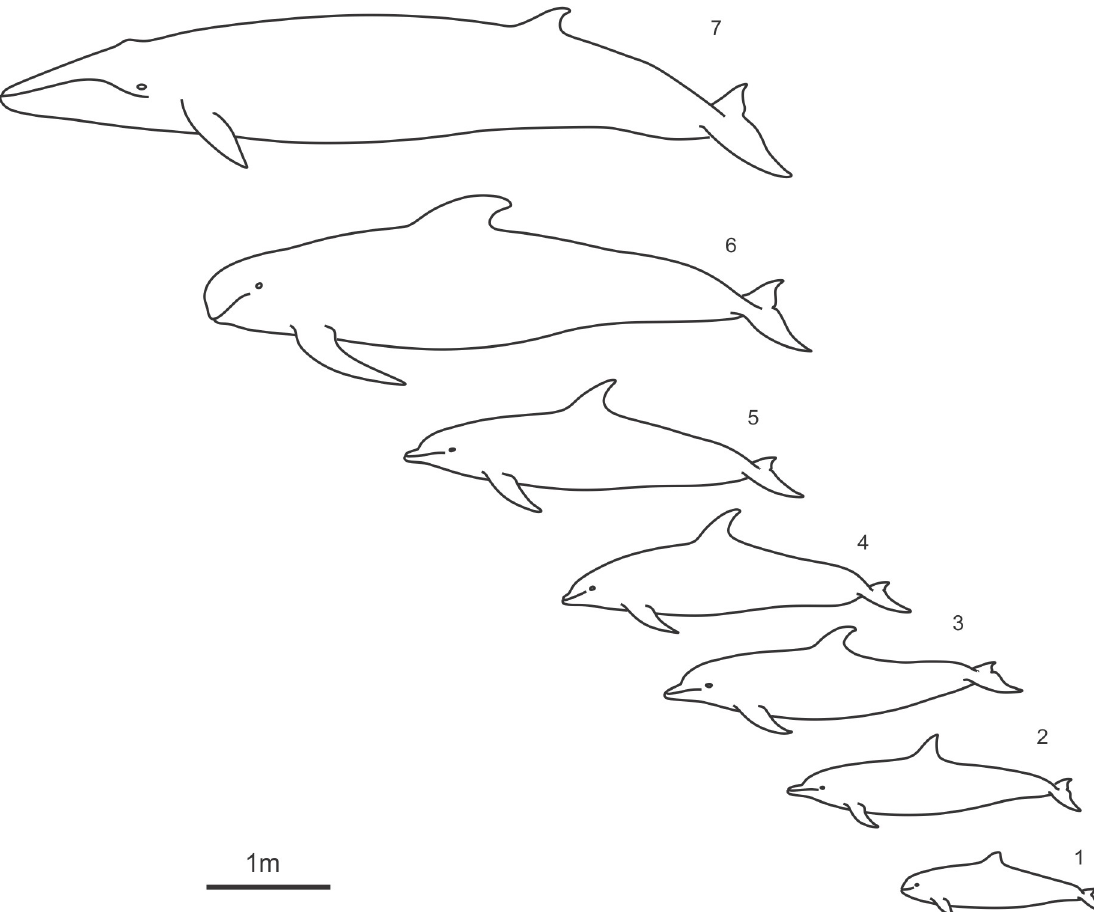
Fig 1. Small cetacean species selected for this study. 1 – Phocoena phocoena , 2 – Delphinus delphis , 3 – Tursiops truncatus , 4 – Lagenorhynchus acutus , 5 – Lagenorhynchus albirostris , 6 – Globicephala melas , 7 – Balaenoptera acutorostrata .